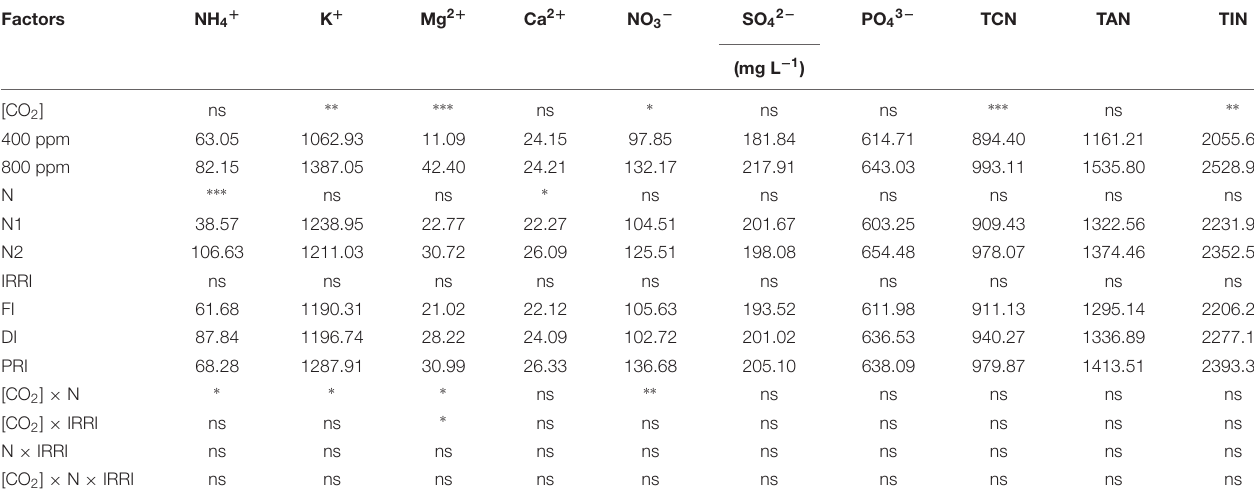
TABLE 2 | Output of three-way ANOVA and mean value on fruit quality parameters of overall ion concentration in tomato plants as affected by the atmospheric [CO 2 ] (400 and 800 ppm), N fertilization rates (N1 and N2), and irrigation regimes (FI, DI, and alternative PRI). Factors